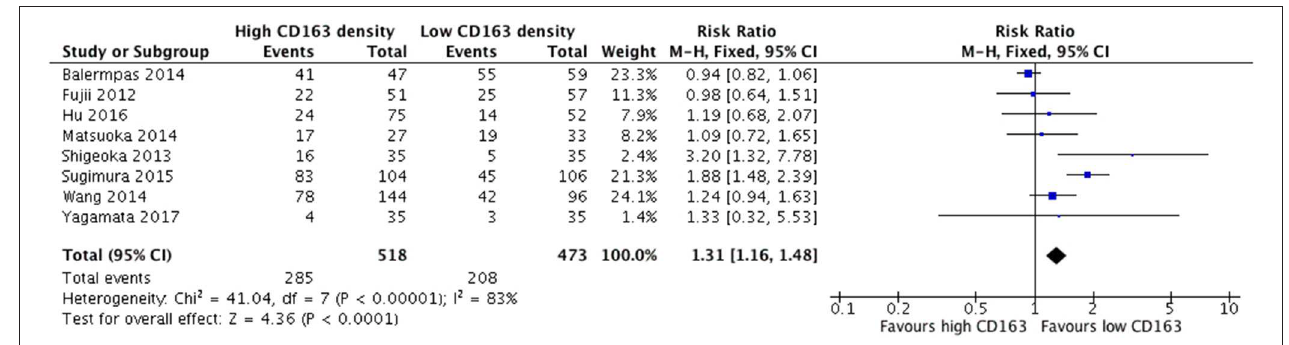
FIGURE 2 | High CD68 + TAM density correlates with advanced T stage (T3, T4).